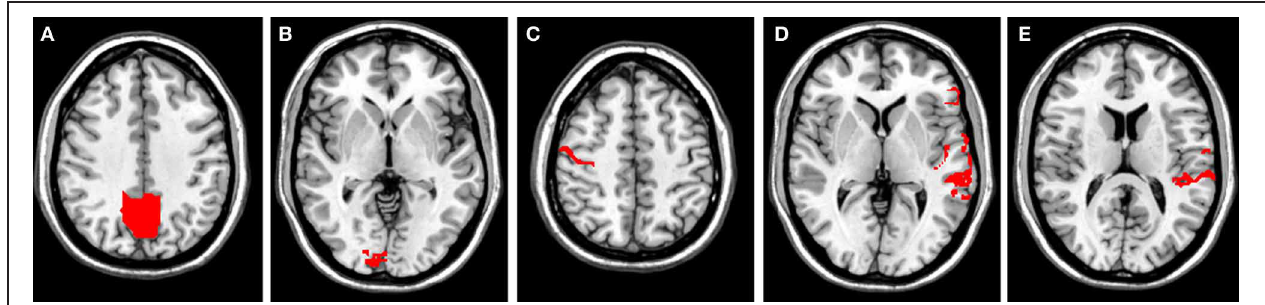
FIGURE 1 | Seed regions (red areas) for all investigated networks. (A) Precuneus (DMN); (B) primary visual cortex (BA17; VIN); (C) right primary motor cortex (BA 4; SMN); (D) left reading areas (RNW); and (E) left auditory cortex (BA 41, BA 42;